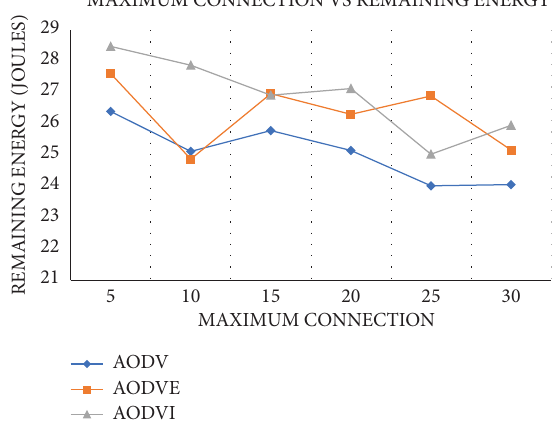
Figure 9: Maximum connection vs remaining energy.